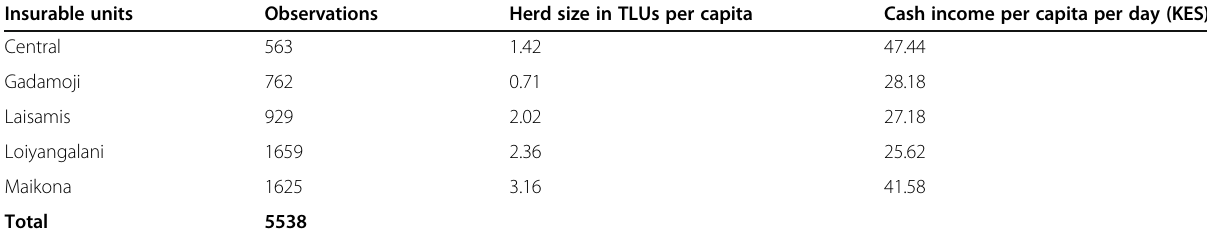
Table 2 Thresholds (pooled means 2009 – 2015) for livelihood classification Insurable